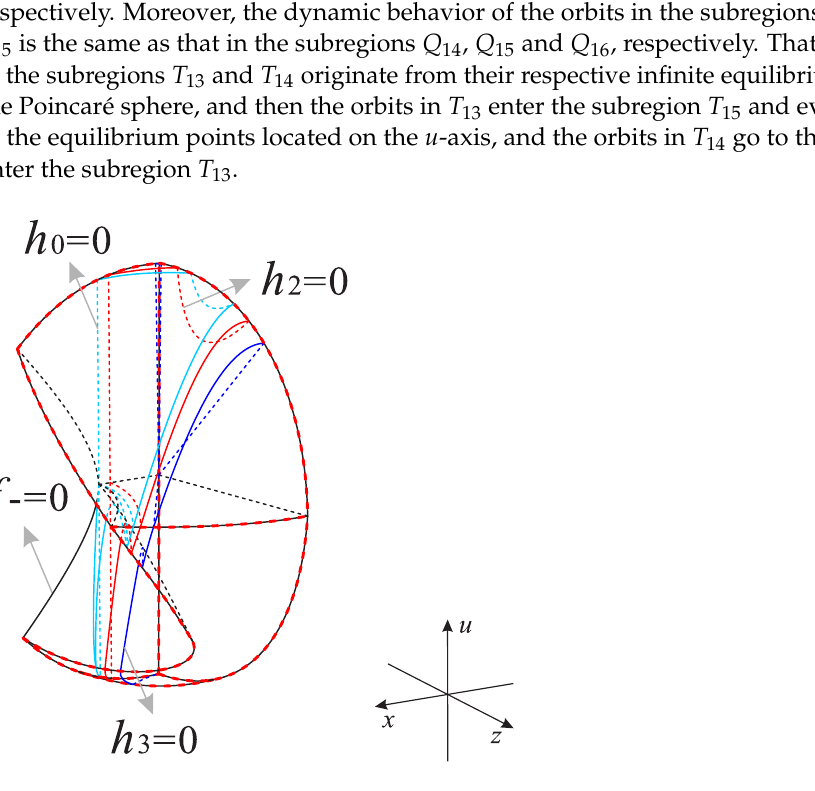
Figure 33. The surfaces h 0 , h 2 and h 3 restricted to the surface f − ( x , z , u ) = 0 and the region T 1 of the Poincaré